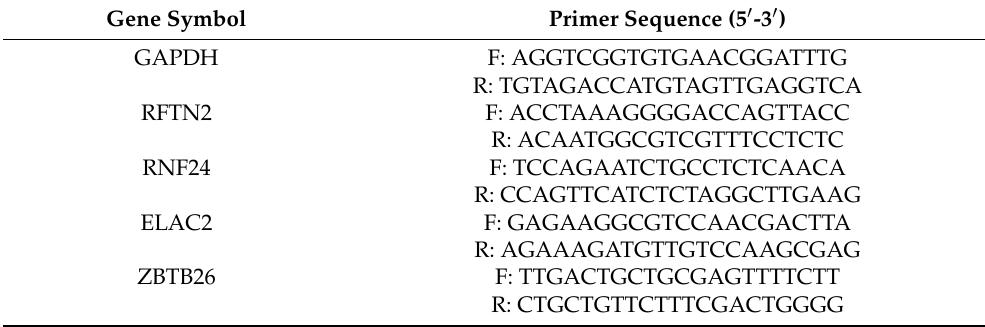
Table 1. Primer sequences for